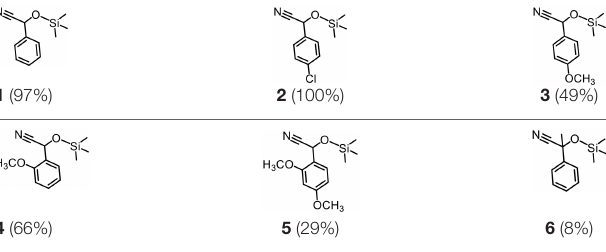
TABLE 1 | The cyanosilylation reaction catalyzed by {TbTeW 6 } a .